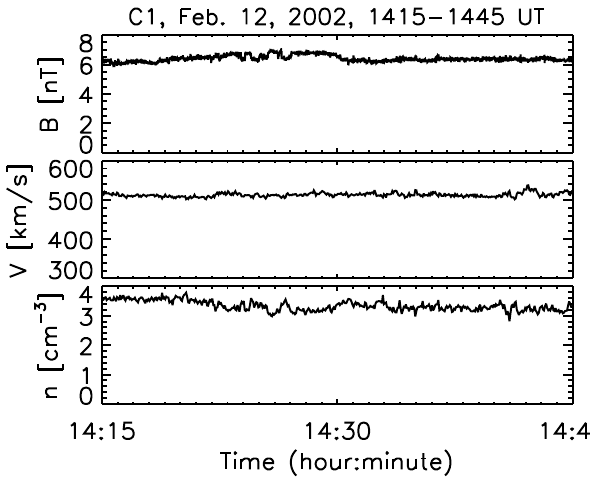
Fig. 7. Time series of the magnetic field magnitude, the ion bulk speed and the ion number density in the solar wind measured by Cluster-1